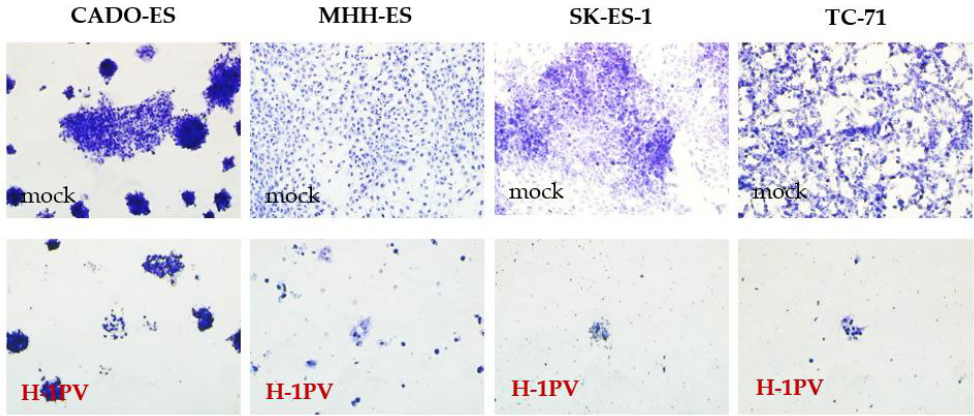
Figure 3. Cytopathic effects of H-1PV infection in Ewing sarcoma cells. Pictures of cells seeded in 96-well plates were taken after staining with crystal violet five days after infection with wild-type Protoparvovirus H-1PV at MOI 1. Magnification: 10 × .